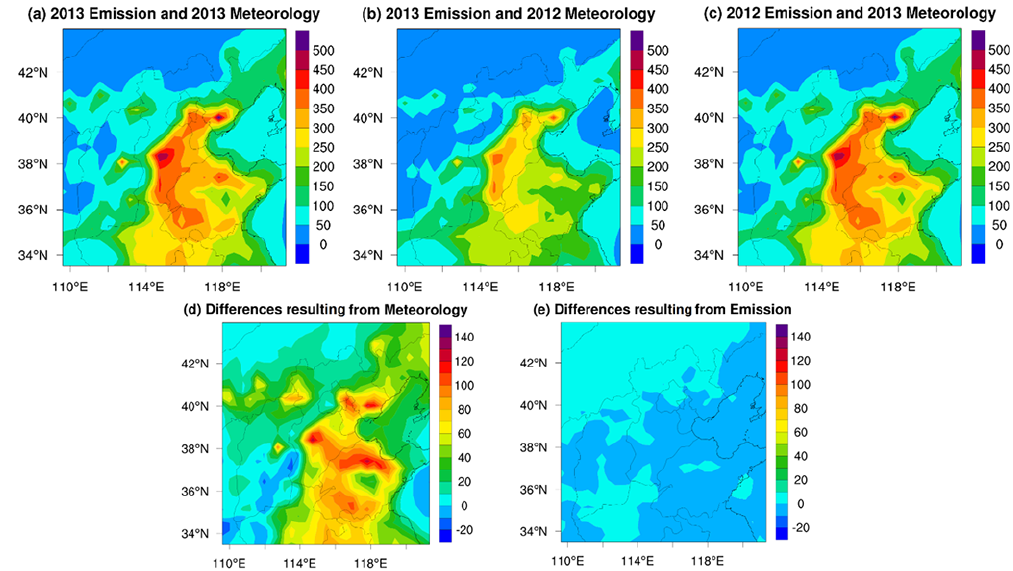
Figure 3. Revised WRF-CMAQ simulated monthly averaged PM 2 . 5 concentration (µgm 3 ) under different scenarios. (a) Base scenario. Actual January 2013 emission and January 2013 meteorology data were used. (b) January 2012 meteorology data were used, and (c) January 2012 emissions were used. The different PM 2 . 5 concentrations (µgm 3 ) caused by meteorology ( d ; equivalent to a–b ) and emission ( e , equivalent to a–c ) are also